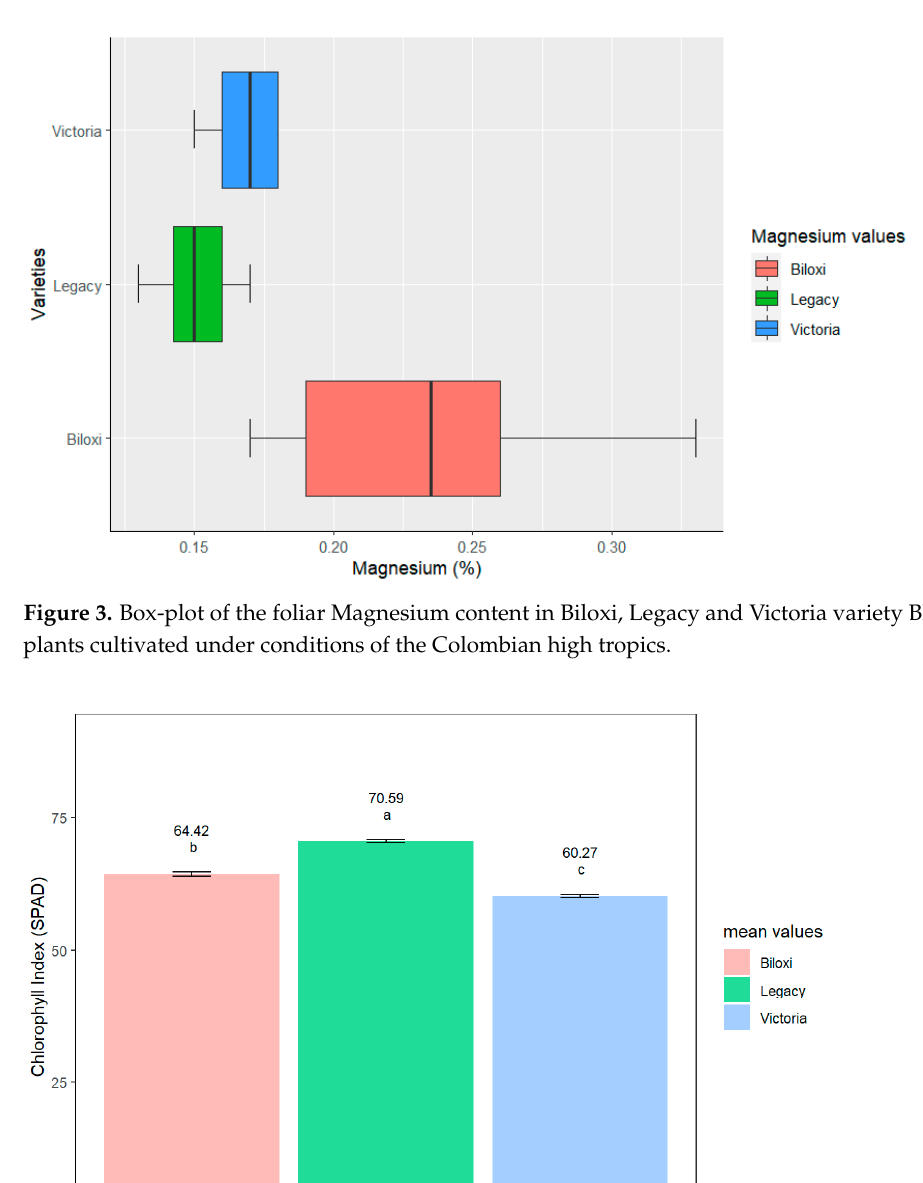
Figure 4. Comparison of SPAD Chlorophyll Index in Biloxi, Legacy and Victoria variety blueberry plants. Different letters indicate significant differences ( p < 0.05) according to the Tukey’s multiple comparison test of means. Vertical bars in each average indicate the standard error (n = 30).